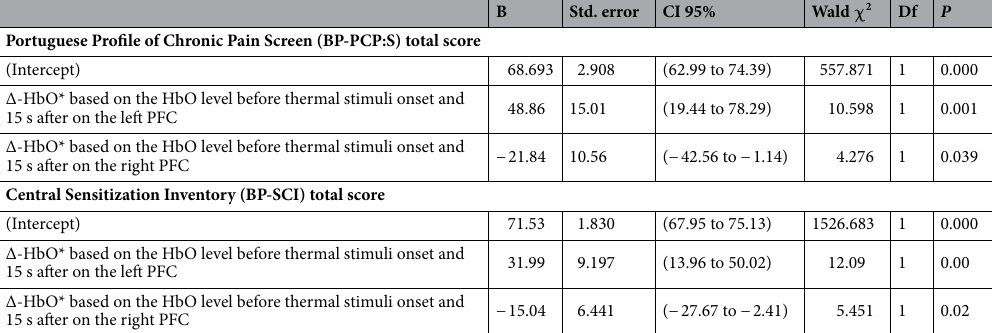
Table 5. Generalized Linear Models of the association between the disability due to pain and central sensitization scores with the ΔHbO peak latency evoked by thermal stimuli on both PFC (n = 22). Prefrontal cortex (PFC); ΔHbO* in millimolar